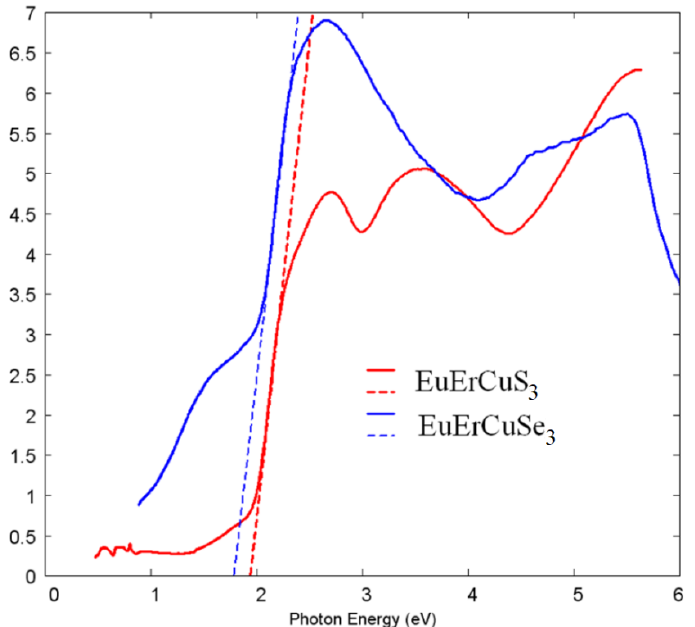
Figure 5. Kubelka–Munk functions and bandgaps for EuErCuSe 3 (blue, E g = 1.79 eV) and EuErCuS 3 (red, E g = 1.94 eV), the sample annealed at 1073 K.